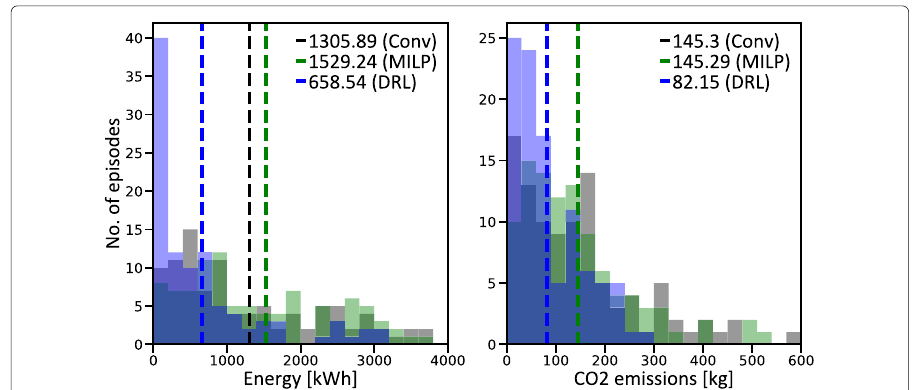
Fig. 9 Distribution and mean value of energy consumption and CO 2 emissions per episode for system A . Black: Conventional controller, Blue: DRL controller, Green: MILP